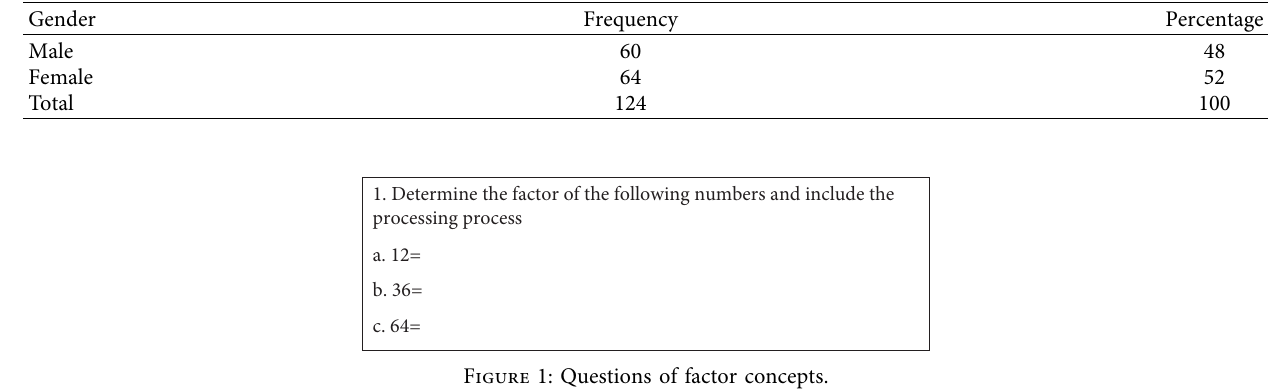
Table 1: Distribution of students according to gender.